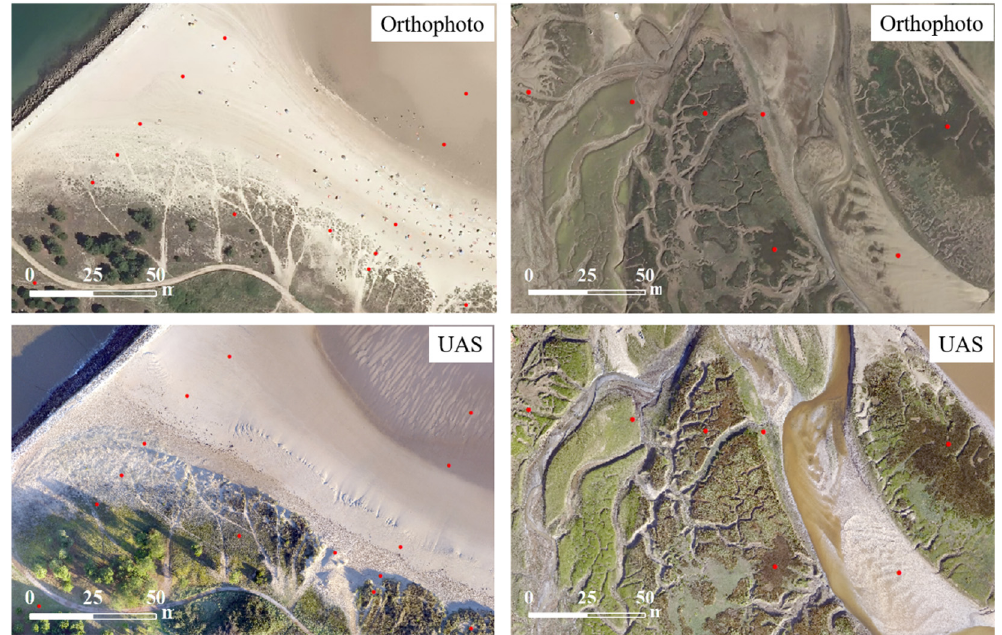
Figure 9. Examples of limitations to feature classification arising in the accuracy assessment for the SVB estuary. The images show the differences between acquisition methods. Left images show the limit between beach and embryo dune habitats; Right images show the limit between saltmarsh (darkest green) and mudflat (covered by macro ‐ algae and seagrasses) features. Red dots indicate test points in the field.